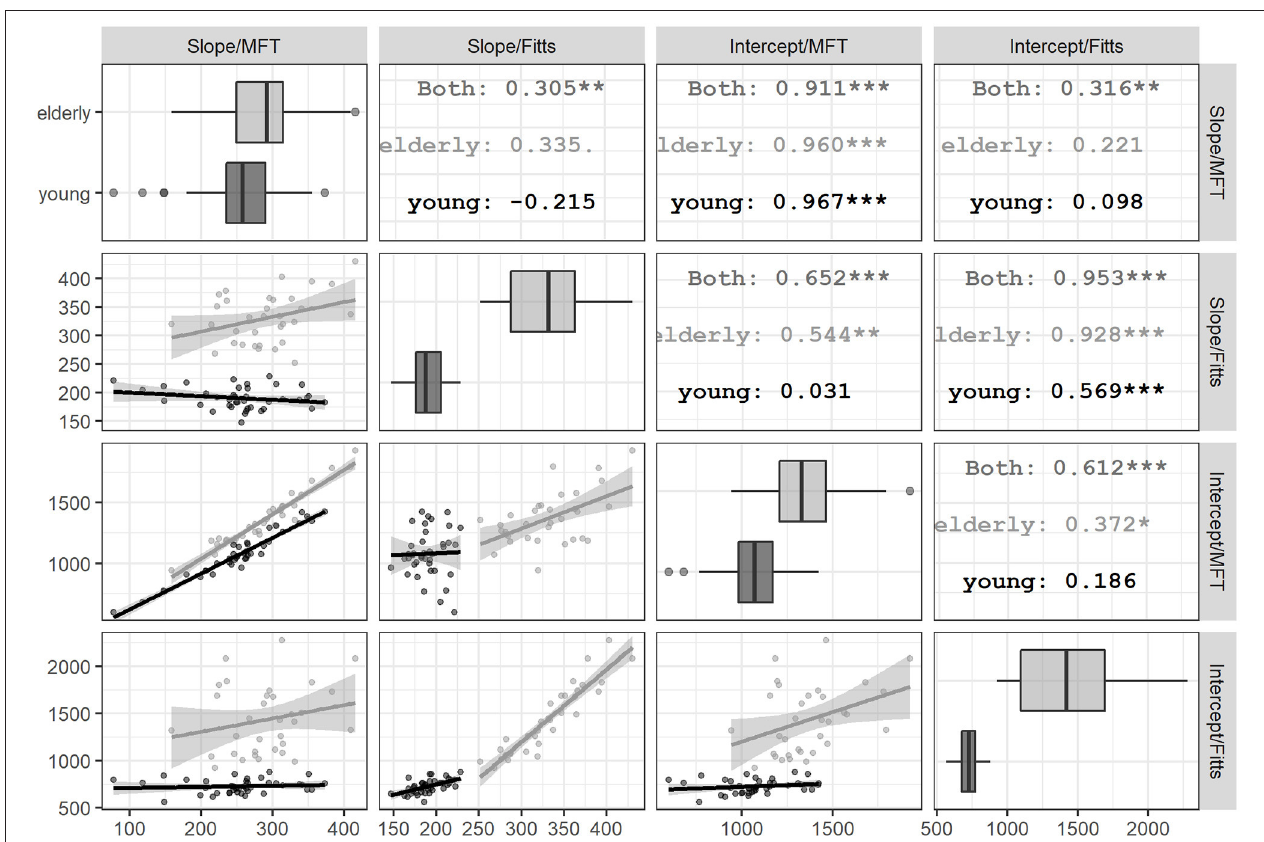
FIGURE 2 | Pairwise correlations among parameters of efficiency functions within each age group. The scatter plots among the slopes and intercepts of MFT and Fitts’ task within each age group are displayed in the off-diagonal cells. For the lower half of the matrix, the column and row titles indicate the parameters represented by the X - and Y -axes of each cell, respectively. For example, the scatter plot at the bottom left corner has column title “Slope/MFT” and row title “Intercept/Fitts,” which indicate dots in this cell represent the relationship between these two parameters in each task. In each cell, black line and dark dots indicate the young group, while gray line and light dots indicate the elderly group. The straight lines and shaded area indicate the simple linear regression lines between the X - and Y -parameters in a cell. Correlation coefficients in the upper-half cells indicate the correlation coefficients of the labeled group in the mirroring cell across the diagonal in the lower-half cells. The asterisks and dots suffixing the coefficients indicate their significance ( p = 0.10, * p = 0.05, ** p = 0.01, and *** p = 0.001). As there are 12 coefficients of interest (i.e., six pairwise combinations for the four parameters out of each age group), after correcting for family-wise error, only those with three asterisks should be considered significant. The diagonal cells show the boxplots of the young and elderly groups for the slopes and intercepts of each task.